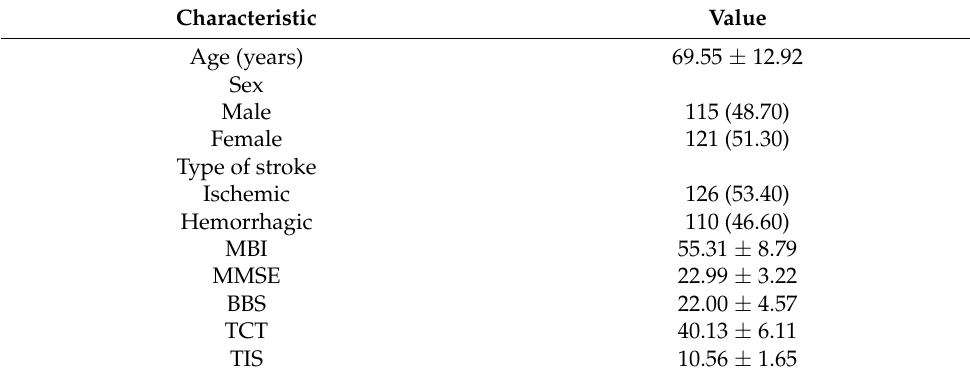
Table 1. Clinical characteristics of the